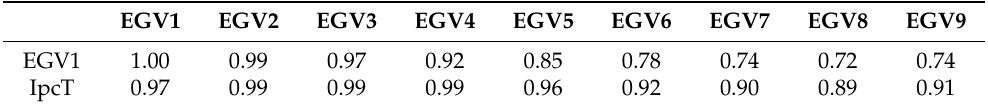
Table 6. Correlations between the estimated EGV1 and the estimated EGV for each calving number and Correlations between the IpcT and the estimated EGV (first 9 calvings